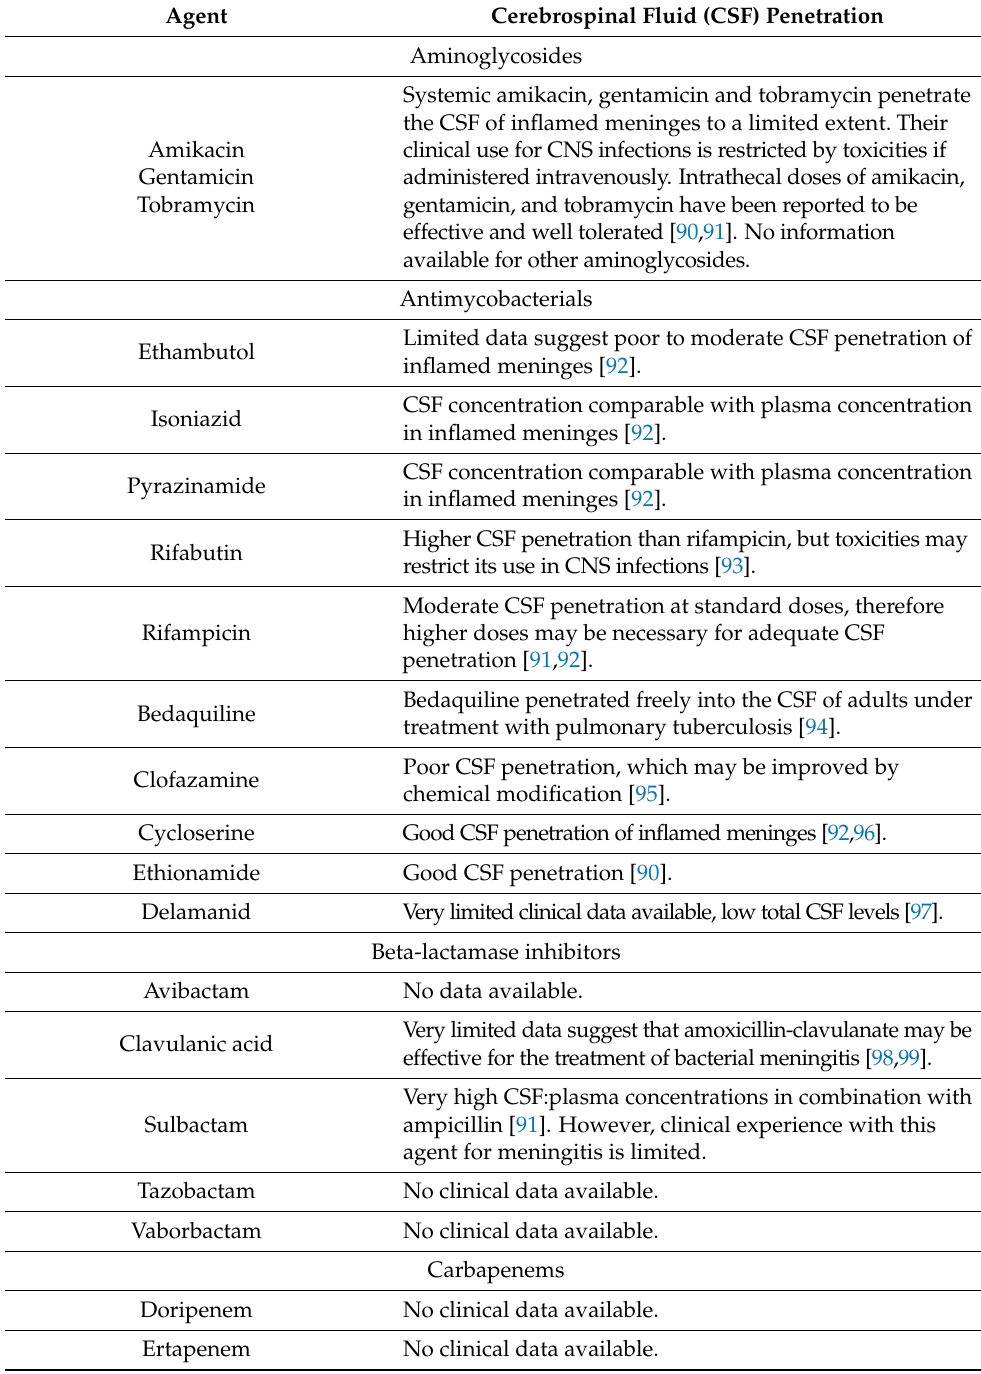
Table 3. Cerebrospinal fluid penetration of